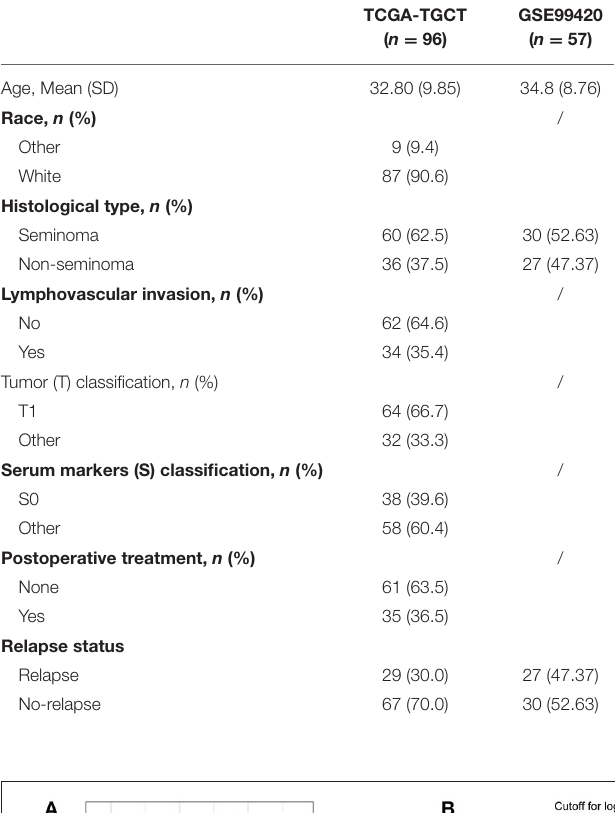
TABLE 1 | Baseline characteristics of Stage I TGCT patients in training and validation cohort.